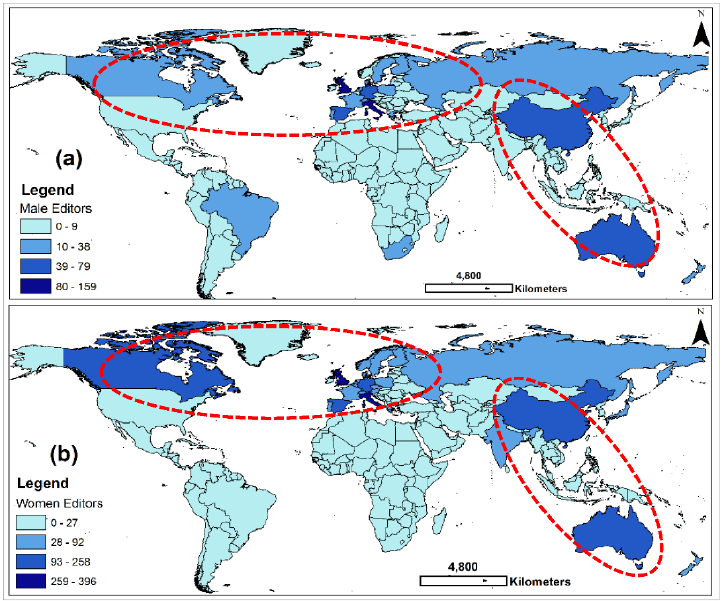
Figure 5. ( a ) shows the geographical distribution of male editorial board members and ( b ) the distribution of female editorial board members.